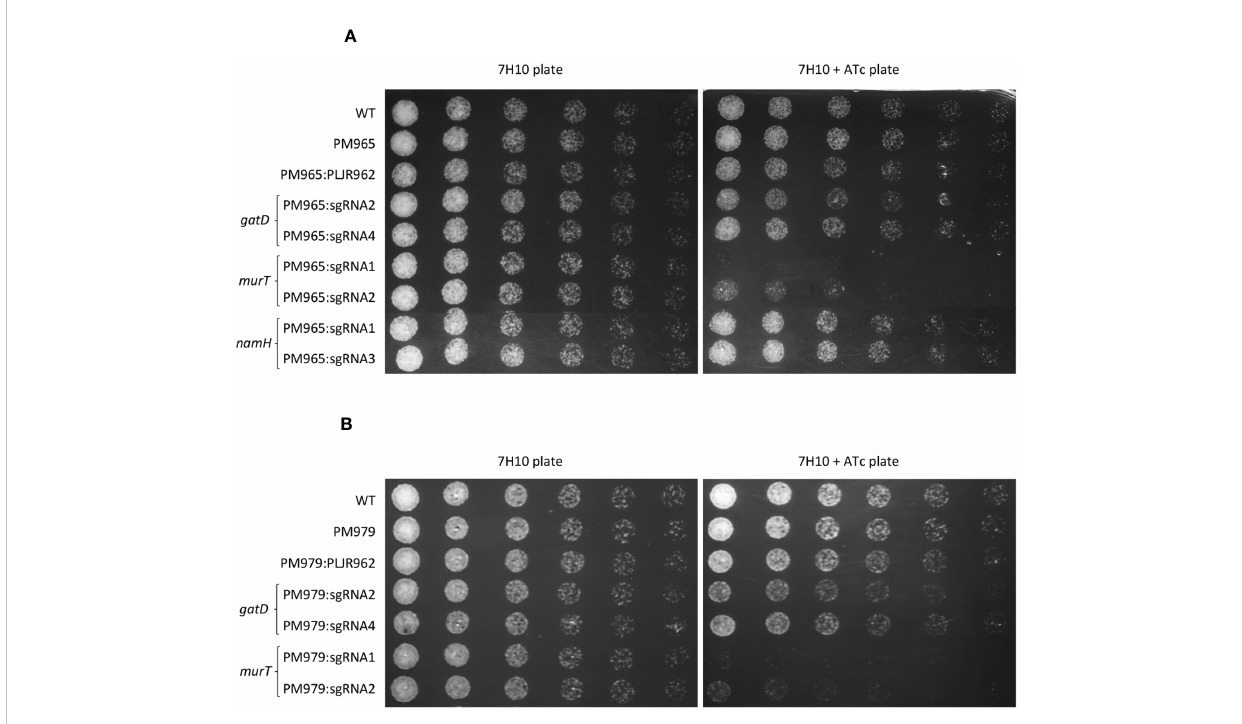
FIGURE 4 Spotting assays of M. smegmatis double and triple mutants (n=3): (A) double mutants, having PM965 ( D blaS1 ) as a parental strain and one target gene repressed; (B) triple mutants, having PM979 ( D blaS1 D namH ) as a parental strain and either murT or gatD repressed. Negative and positive controls were included in all experiments. The fi rst spots were normalized to an OD 600 of 0.001 and the next were performed by preparing and spotting 2-fold serial dilutions of each culture on agar